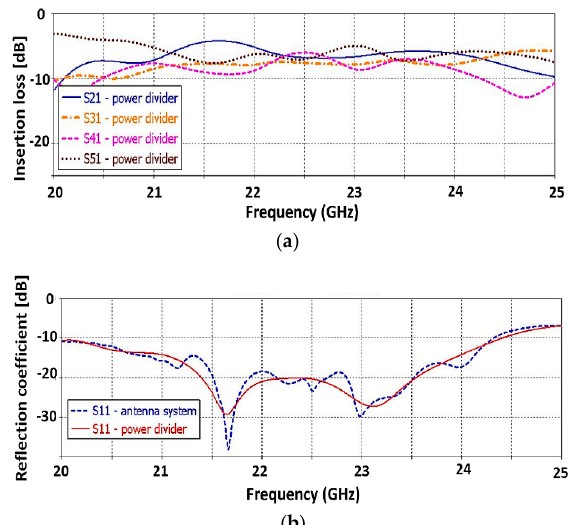
Figure 21. ( a ) Power levels of four port power divider; ( b ) reflection coefficient of Vivaldi antenna array with four-way SIW power divider.